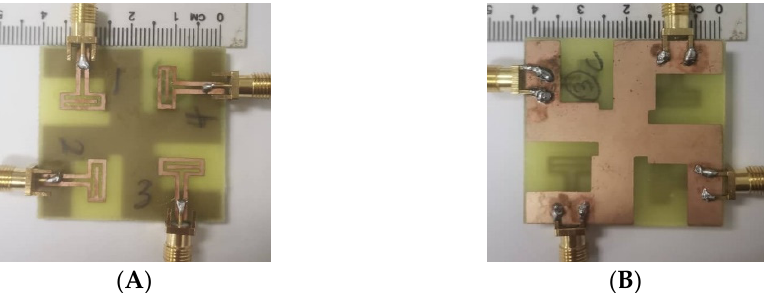
Figure 6. Fabricated prototype of the proposed antenna design: ( A ) top view and ( B ) bottom view.